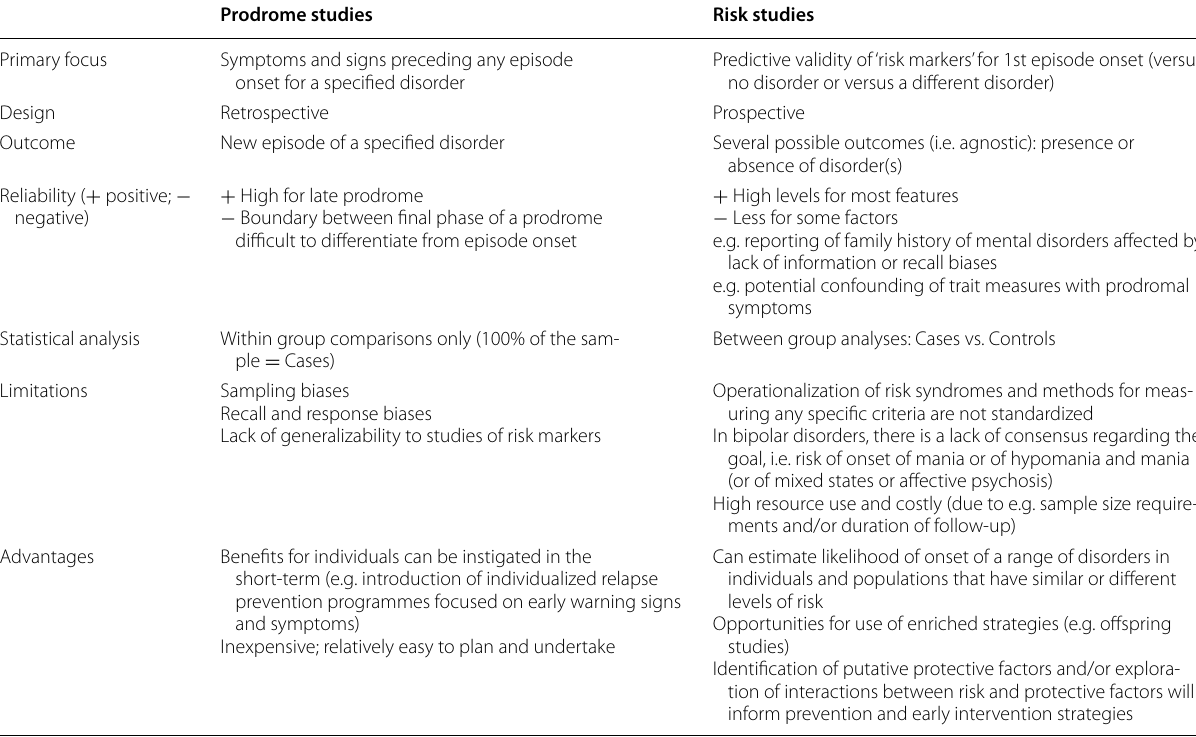
Table 1 Main characteristics of studies of prodromes and risk